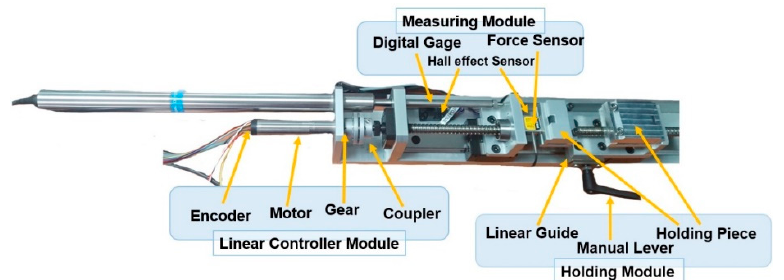
Figure 1. Quantifying device (QD) consisting of a linear controller module, holding module, and measuring module. measuring